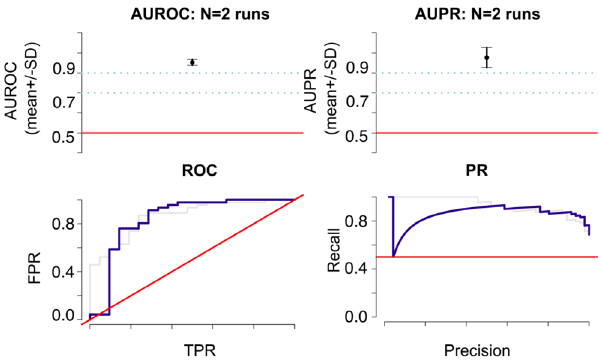
Figure 3. Average model performance for binary classification of breast tumour as “LumA” or “other” using clinical and transcriptomic data. Clockwise from top-left: Mean area under ROC curve across train/test splits; mean area under precision-recall curve; precision-recall curve (average in blue; individual splits in grey); ROC curves (average in blue; individual splits in